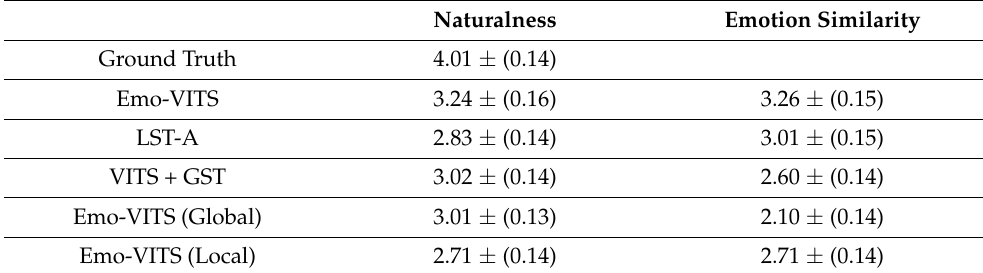
Table 3. MOS with 95% confidence interval on Pm